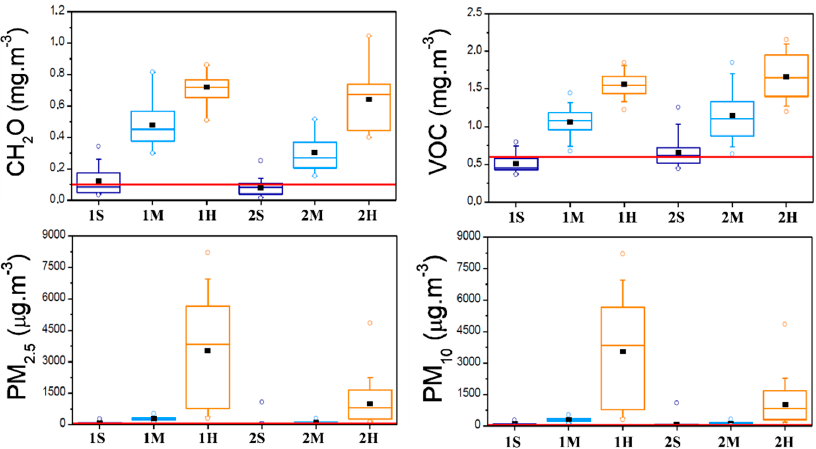
Figure 12. Indoor air pollutants for the studied toasting scenarios at two dwellings (1 and 2): S—slightly toasted, M—medium toasted; H—heavily toasted. The red line represents the limit values of the Portuguese legislation [32]. The box plot represents mean (black square), the quartiles (5%, 25%, median, 75% and 95%) and lower circle the minimum value while the upper circle represents the maximum